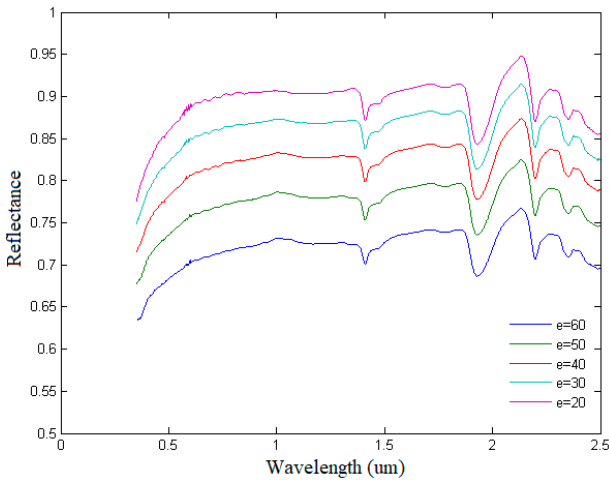
Figure 14. Simulated spectra of plagioclase.